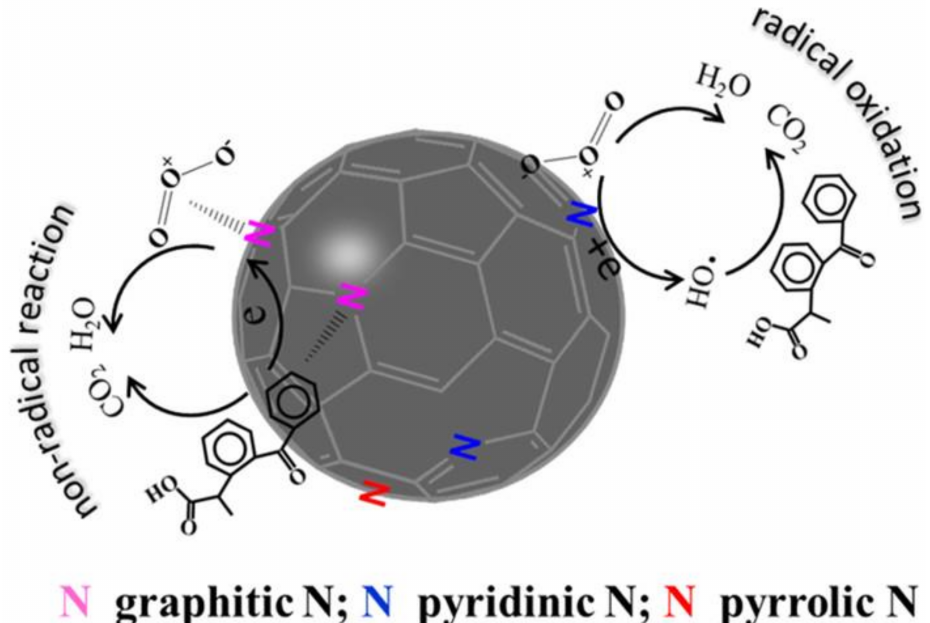
Figure 2. Mechanism of KET degradation by N-doped carbon. Reprinted with permission from Sun et al. [79]. Copyright 2019 American Chemical